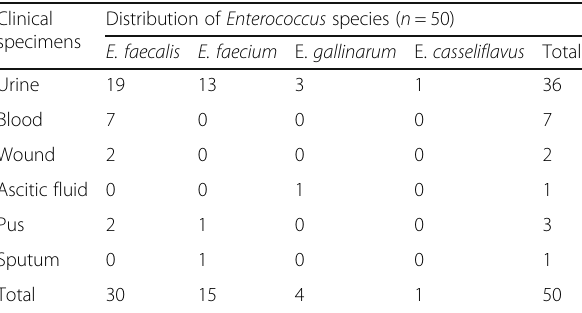
Table 2 Distribution of HLAR Enterococcus species from various clinical specimens Clinical Distribution of Enterococcus species ( n = 50) specimens